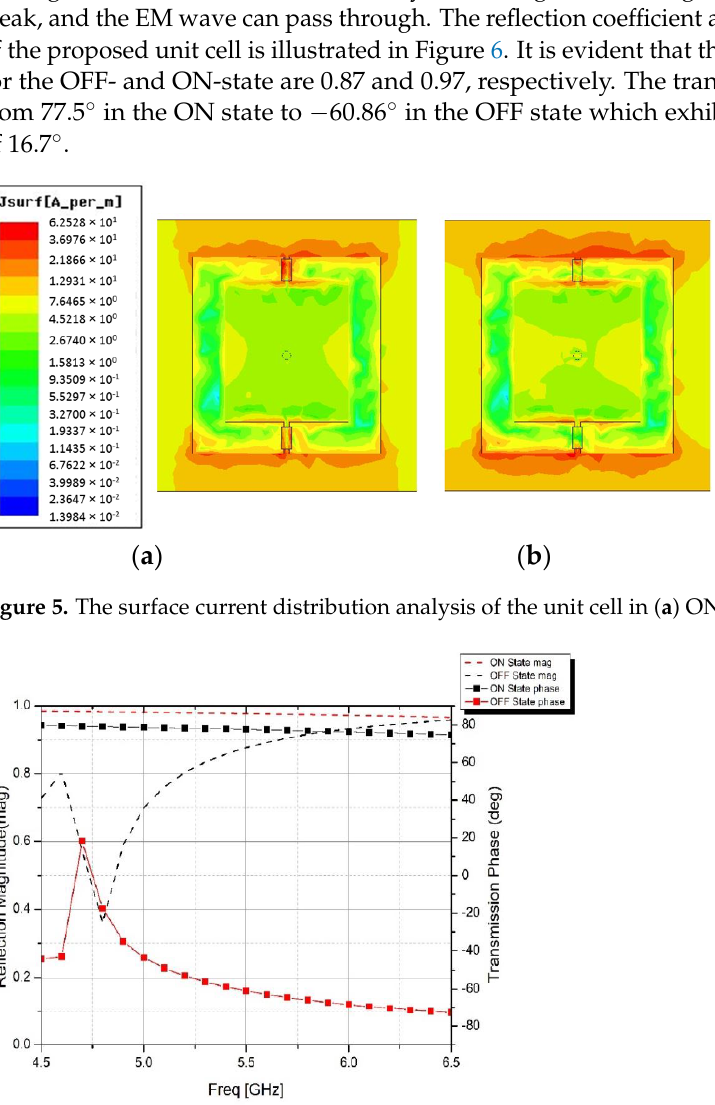
Figure 6. The reflection coefficient magnitude and the transmission coefficient phase results of the PRS unit cell.